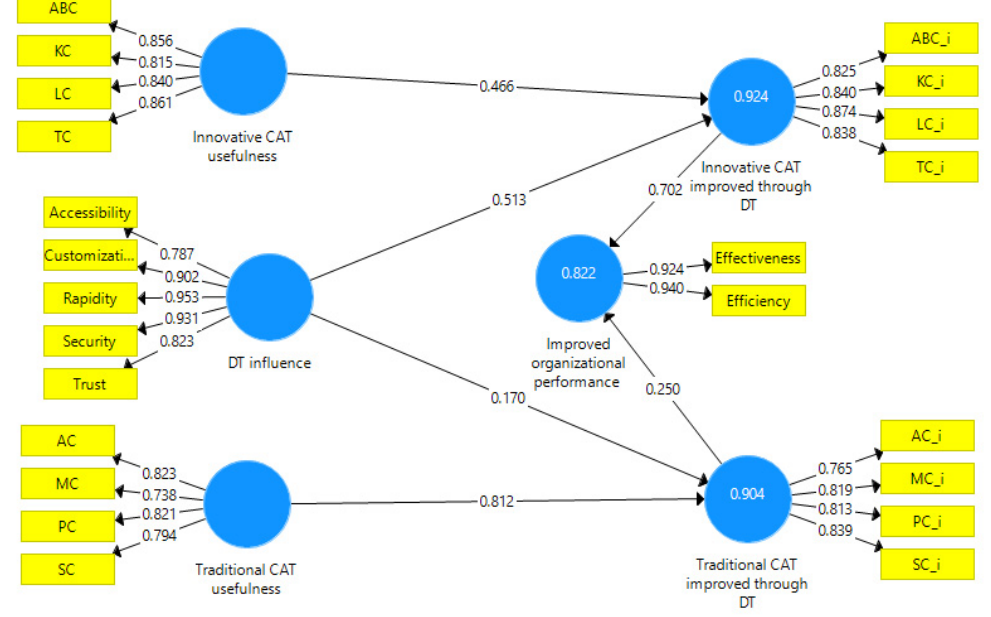
Figure 2. Empirical model. Source: own construction using SmartPLS v3.0 (SmartPLS GmbH, Oststeinbek, Germany).